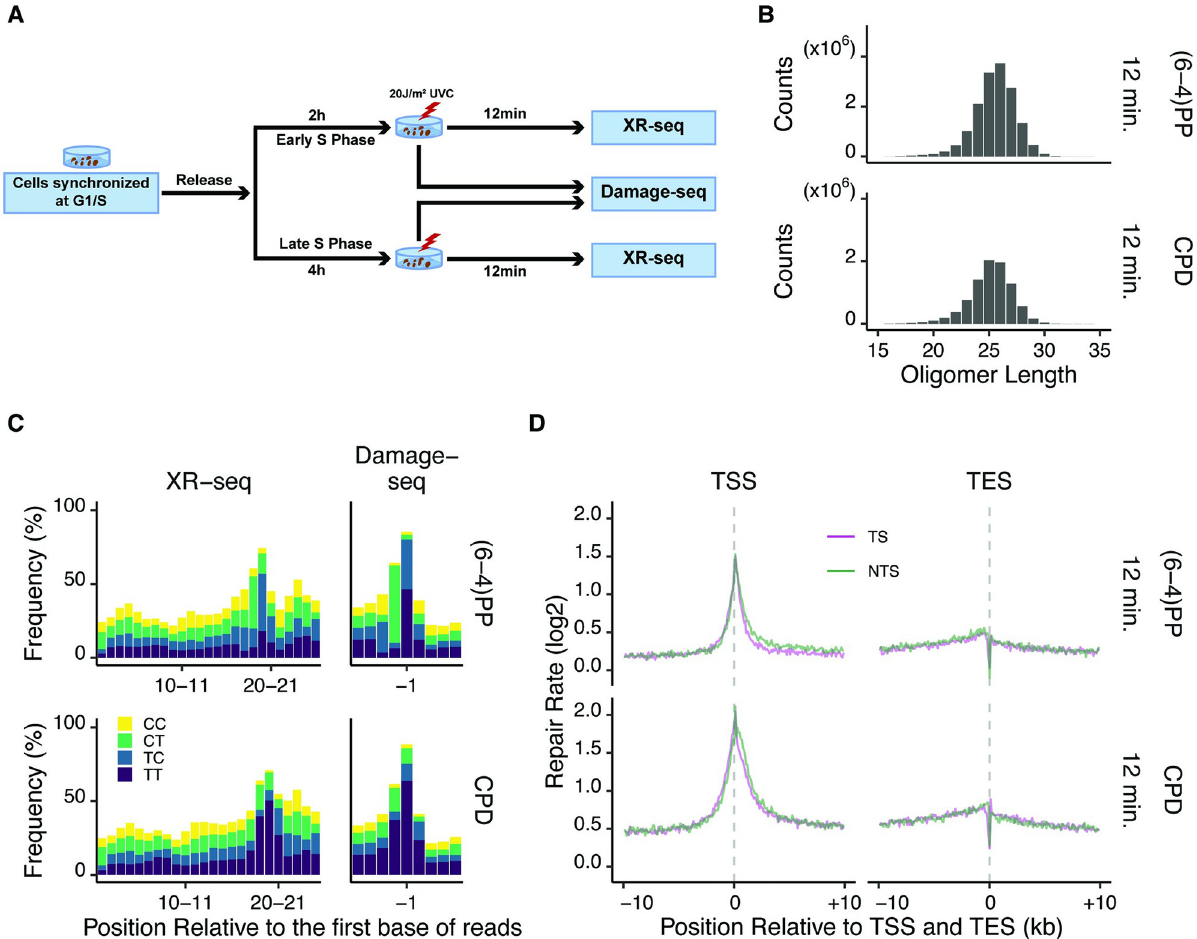
Fig 1. Damage and repair maps of UV-irradiated synchronized HeLa cells. (A) Schematic of experiment design. HeLa cells were synchronized and exposed to 20J/m 2 UVC. Immediately or 12 minutes after UV irradiation, they were collected to perform Damage-seq or XR-seq, respectively. (B) Distribution of oligomer length of XR-seq reads of (6–4)PPs and CPDs in late S phase. (C) Dipyrimidine content of 26-nucleotide-long XR-seq and 10 nucleotides around the first nucleotide of Damage-seq reads of (6–4)PPs and CPDs in late S phase. Because the DNA polymerase stops right before adducts during Damage-seq, the expected damage sites should be at -1 position. (D) Repair rates [log2 (XR-seq/Damage-seq)] of template strands (TS) and non-template strands (NTS) around transcription start sites (TSS) and end sites (TES). (B-C) Replicate A is shown. (D) Replicate A and B are